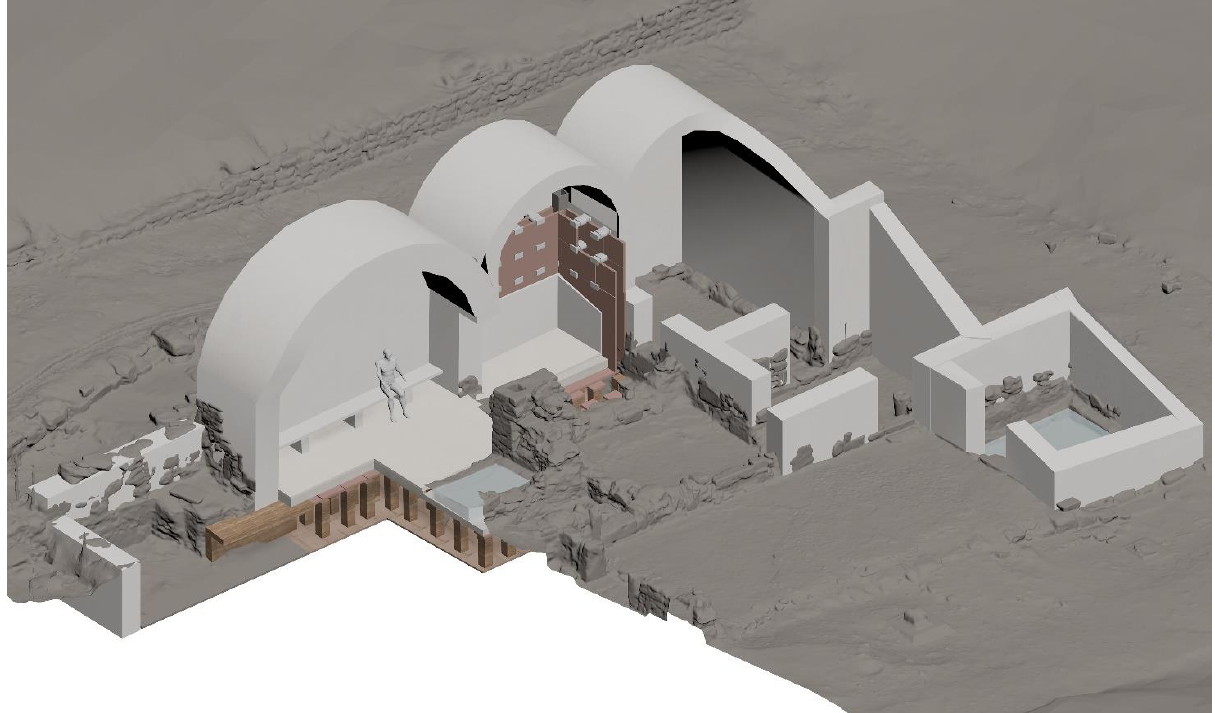
Figure 7. Virtual reconstruction of the bath, Axonometric